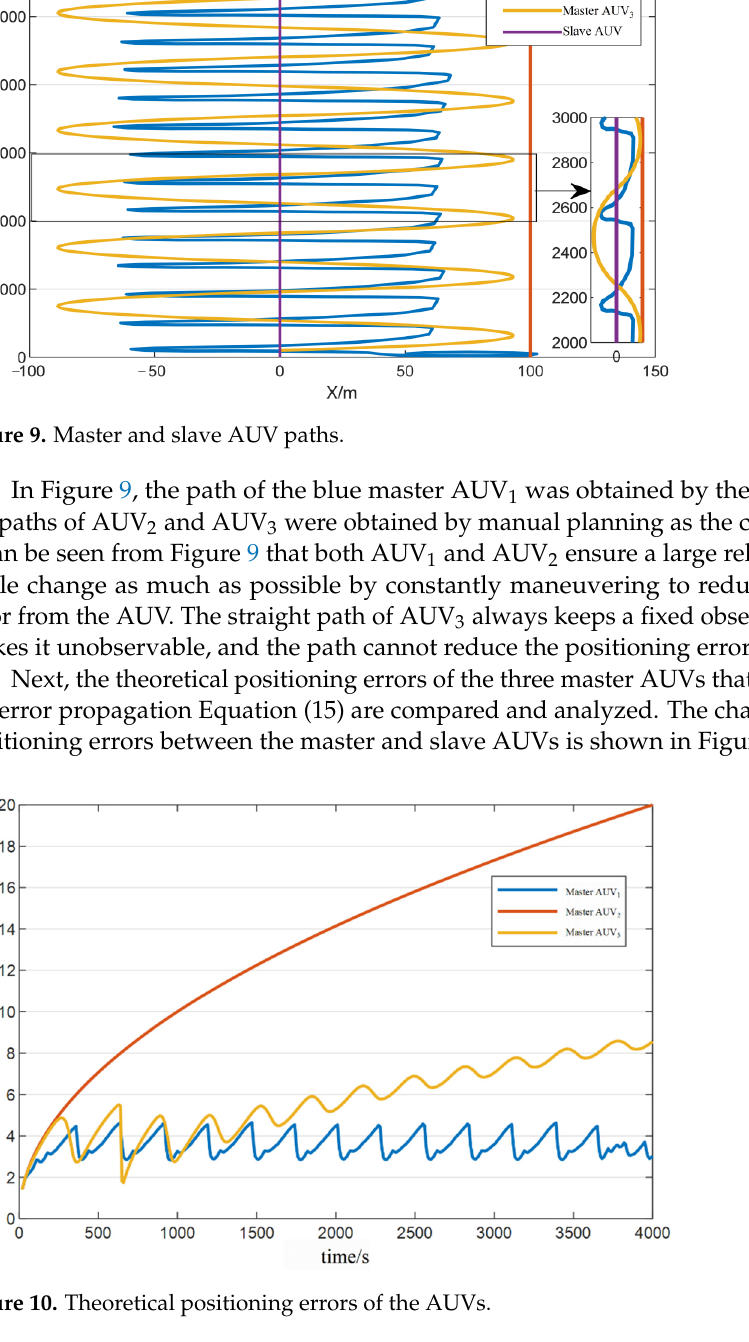
Table 4. Theoretical positioning errors of the AUVs.